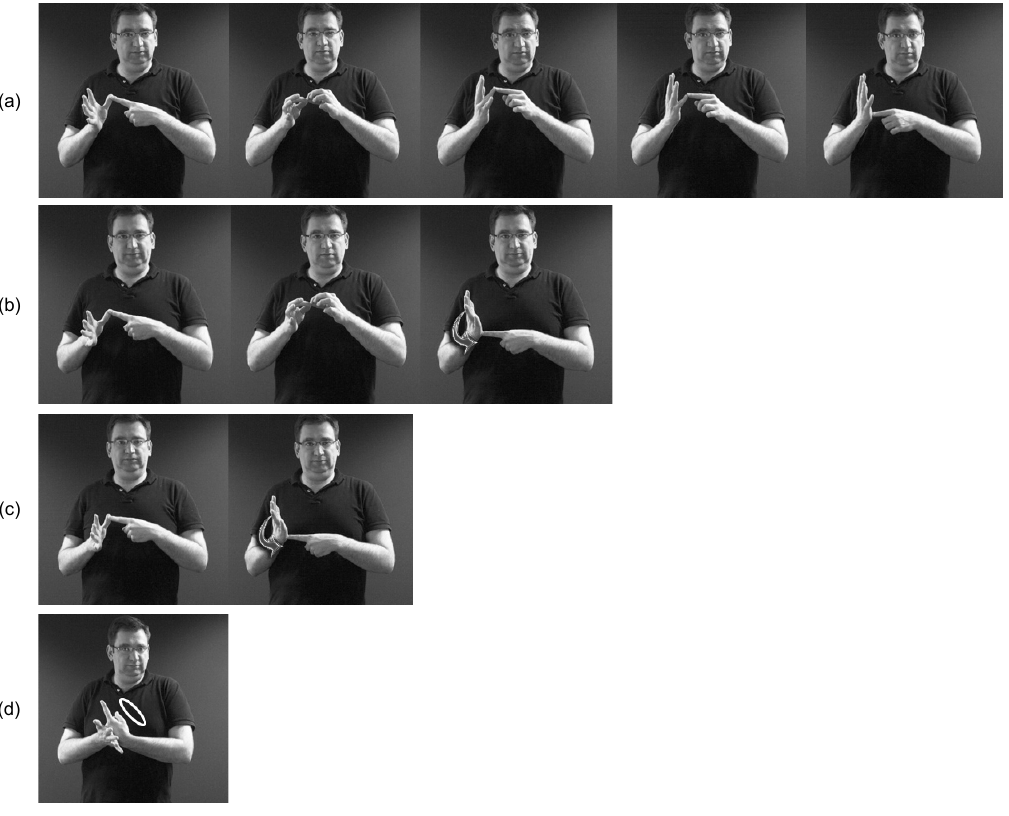
Figure 20: Nativisation pathway in BSL from fully fingerspelled (a) -a-b-o-u-t- to (b) -a-b-t- to (c) about to (d) about03* (from Cormier et al.